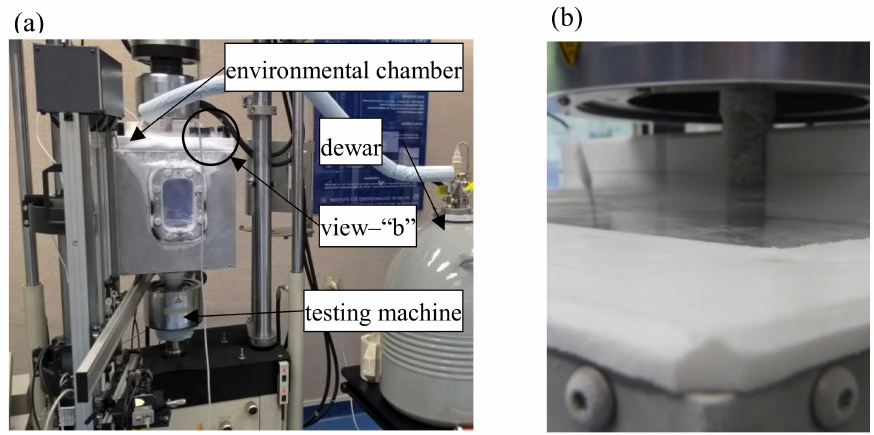
Figure 3. Environmental chamber used for tests at cryogenic temperature, ( a ) chamber mounted in a strength testing machine and ( b ) view of the machine